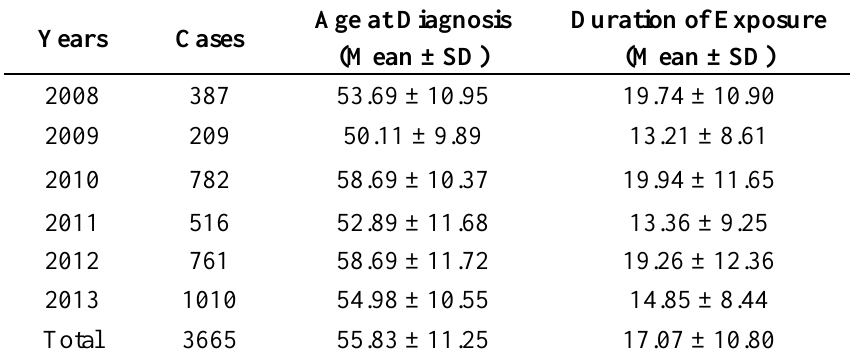
Table 1. Age at diagnosis and duration of exposure from 2008 to